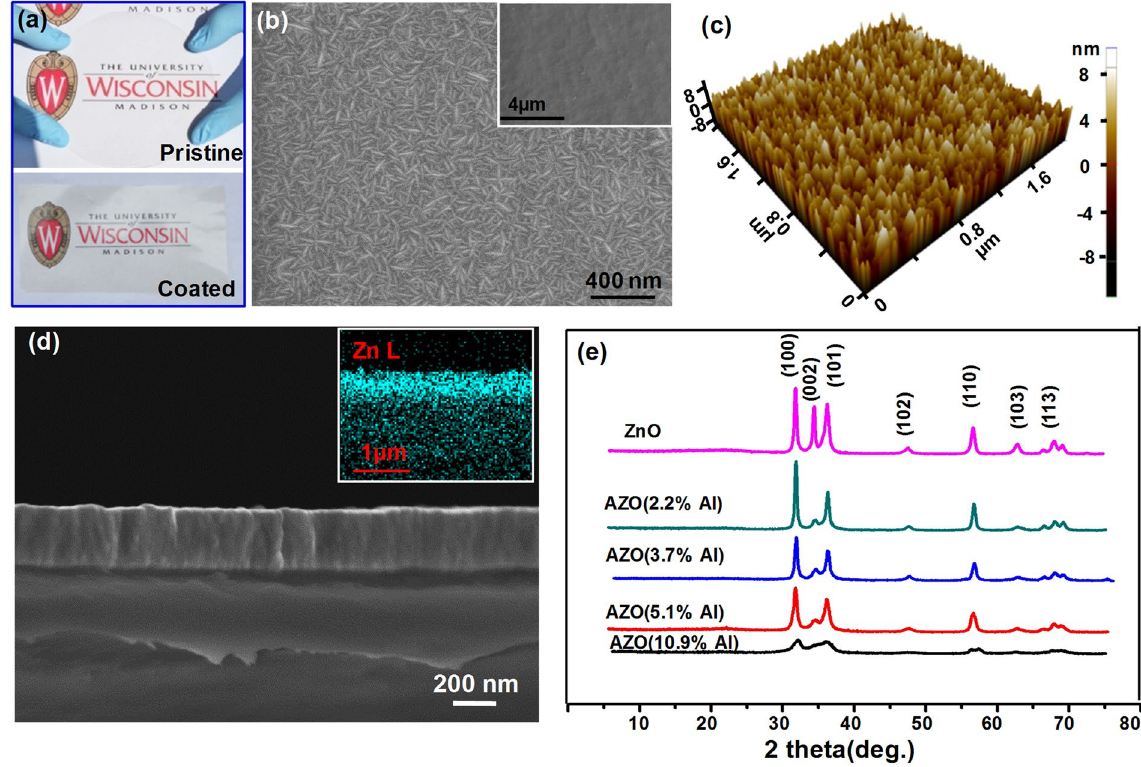
Figure 1. Morphology and crystal structure of AZO-CNF papers. ( a ) Optical image of an as-fabricated CNF paper from the CNF gel (Top) and an AZO-coated CNF paper (Bottom). ( b ) SEM image of the AZO surface with 3.7 at.% Al showing the typical worm-like surface morphology. Inset is a low-magnification SEM image showing the flat surface over a large area. ( c ) AFM image of the AZO surface with 3.7 at.% Al